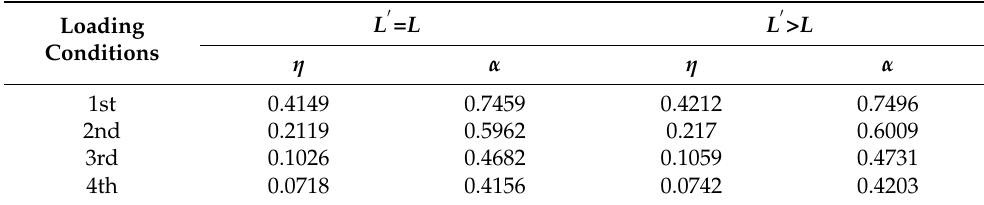
Table 3. Effective ratios of the transverse bending rigidity and thickness reduction coefficients un- der different loading conditions.